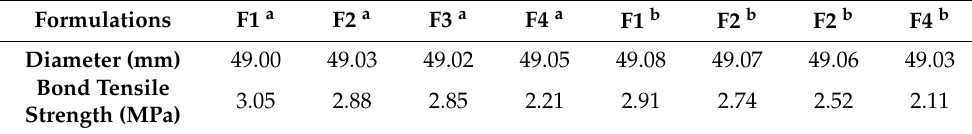
Table 6. Tensile bond strength of SN-modified underwater composite-repairing